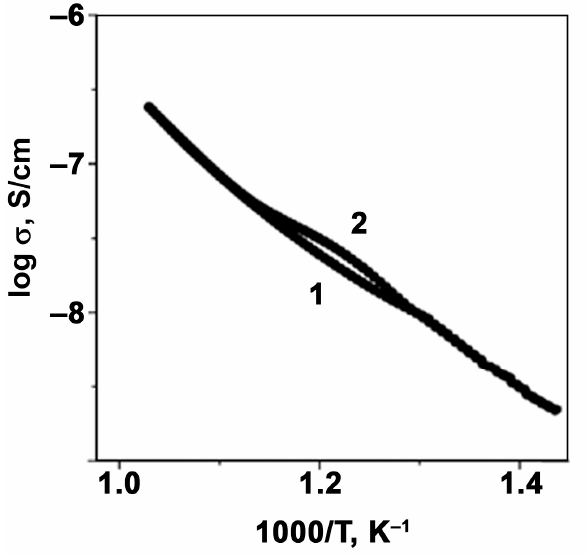
Figure 4. Electric conductivity of Ca 8 MnEu(PO 4 ) at 50 kHz on heating (1) and cooling